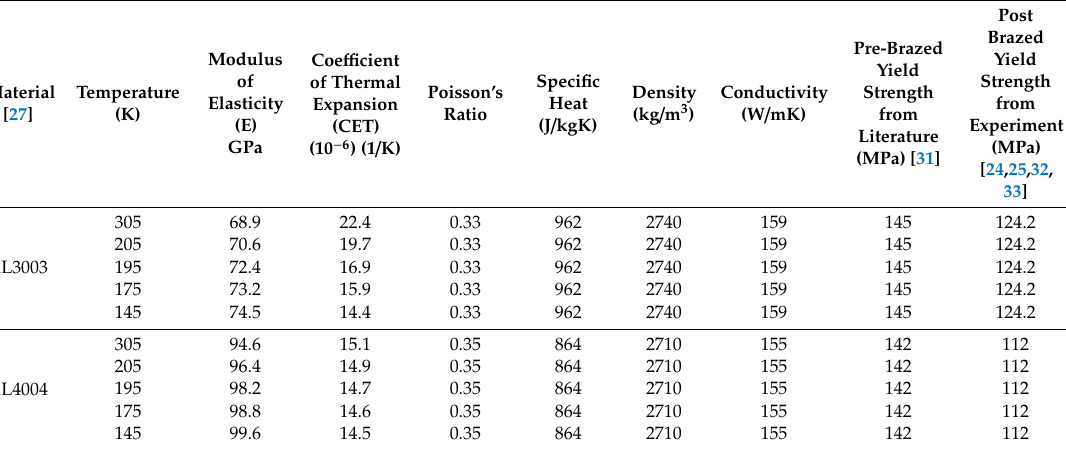
Table 2. Properties of material used for